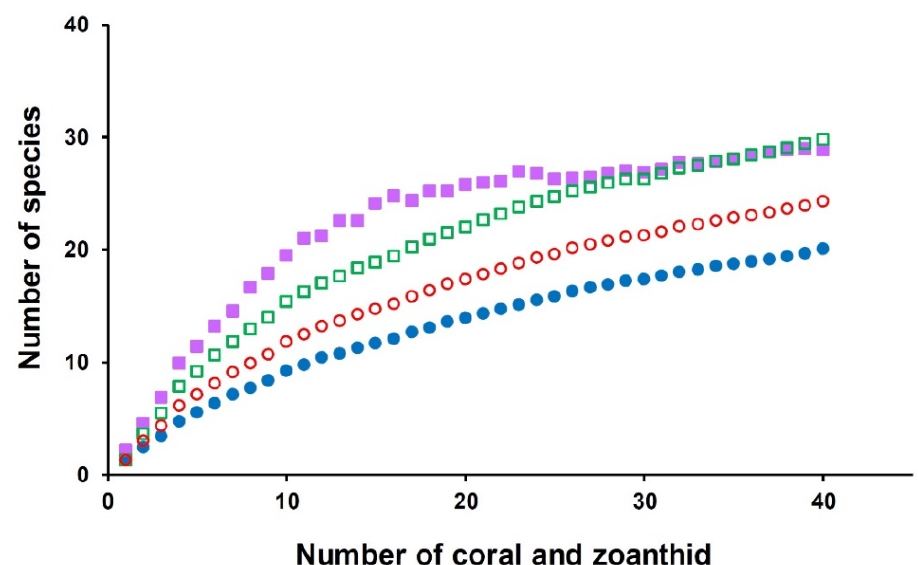
Figure 3. The number of yeast species observed (filled blue circle) from corals and zoanthids, and estimated species richness: Chao 1 (filled purple square), Jack 1 (unfilled square), and bootstrap (unfilled circle) were plotted.